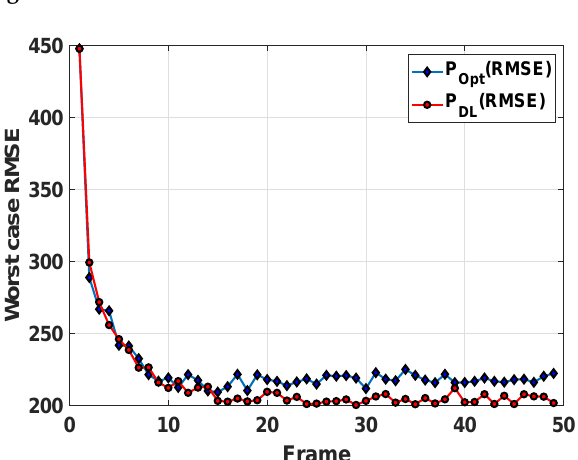
Figure 11. The worst case RMSEs.